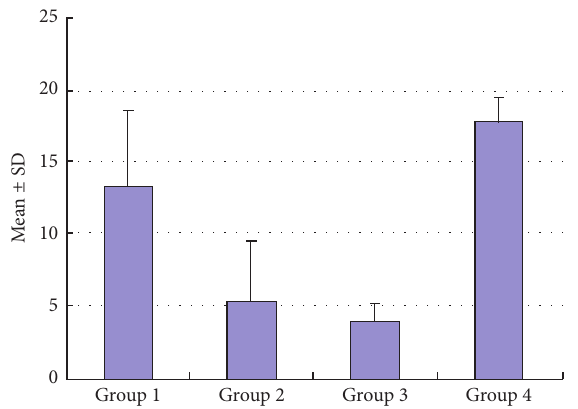
Figure 5: Immunohistochemical analysis of MVD in peritoneal tumor nodules (mean ±